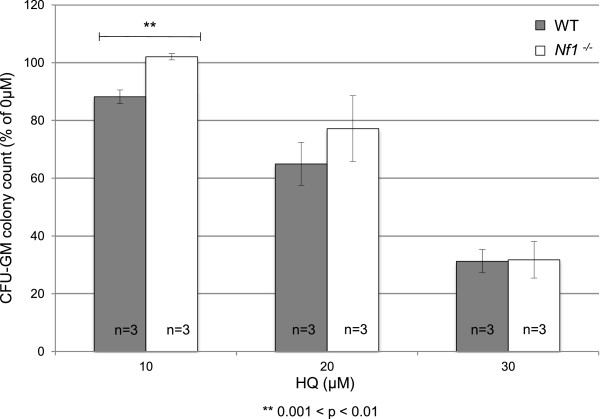
Nf1−/− hematopoietic progenitors of the granulocyte and macrophage lineages are resistant to HQ-induced toxicity. CFU-GM colony counts, relative to untreated controls, are plotted vs. HQ exposure level for cultures derived from both WT and Nf1−/− BM. Bone marrow cells from each genotype were treated with HQ in MethoCult® capable of inducing growth of CFU-GM colonies and then cultured for 12 days. In both genotypes colony formation was reduced upon exposure to as little as 10 μM HQ. CFU-GM numbers continued to fall with increasing HQ exposure up to 30 μM HQ treatment, and at all doses the Nf1−/− BM appeared resistant to HQ-induced toxicity when compared with BM from WT littermates.